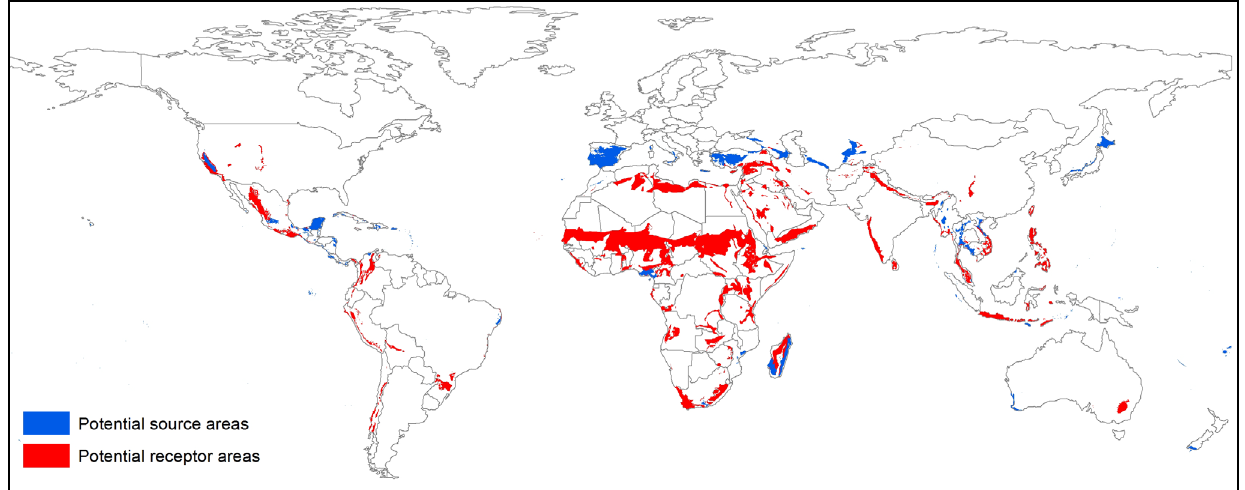
Figure 3C. Global map of potential source (in blue) and receptor areas (in red) as defined in the legend of Figure 3A & Figure